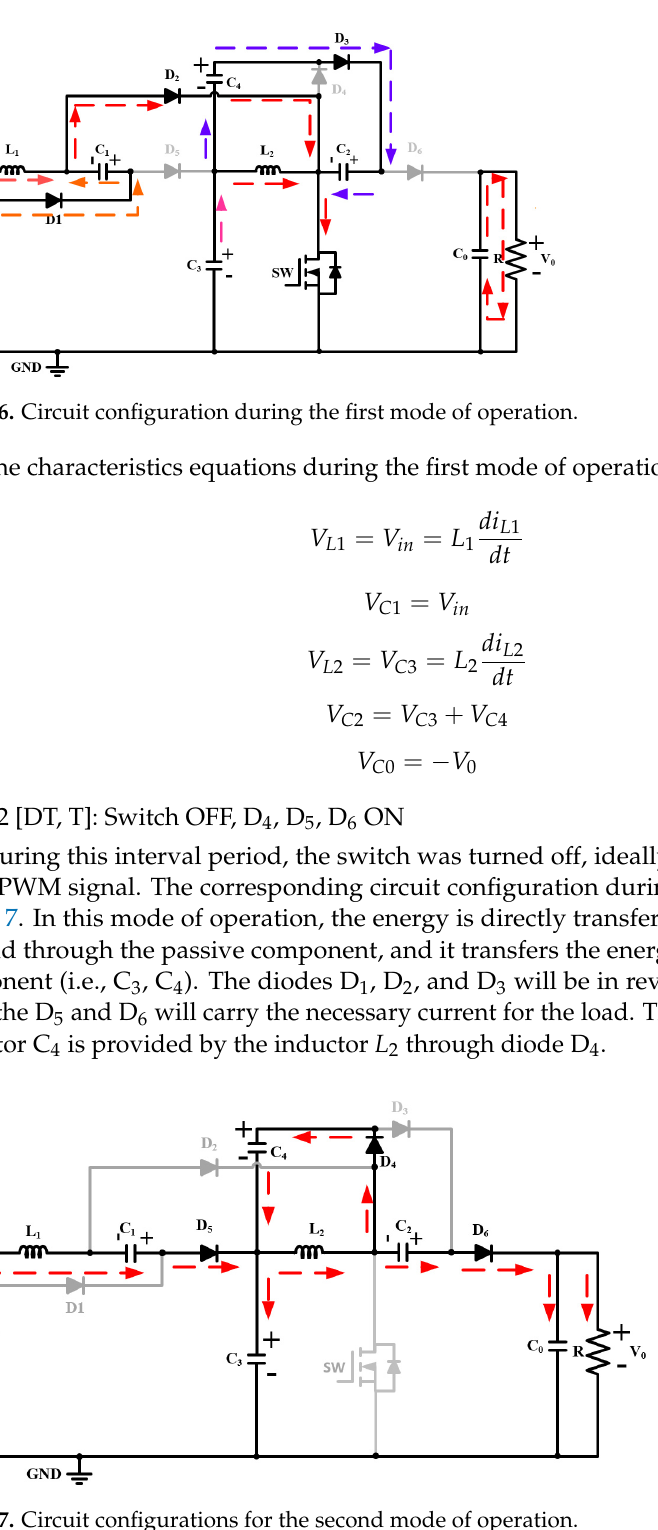
Figure 7. Circuit configurations for the second mode of operation.